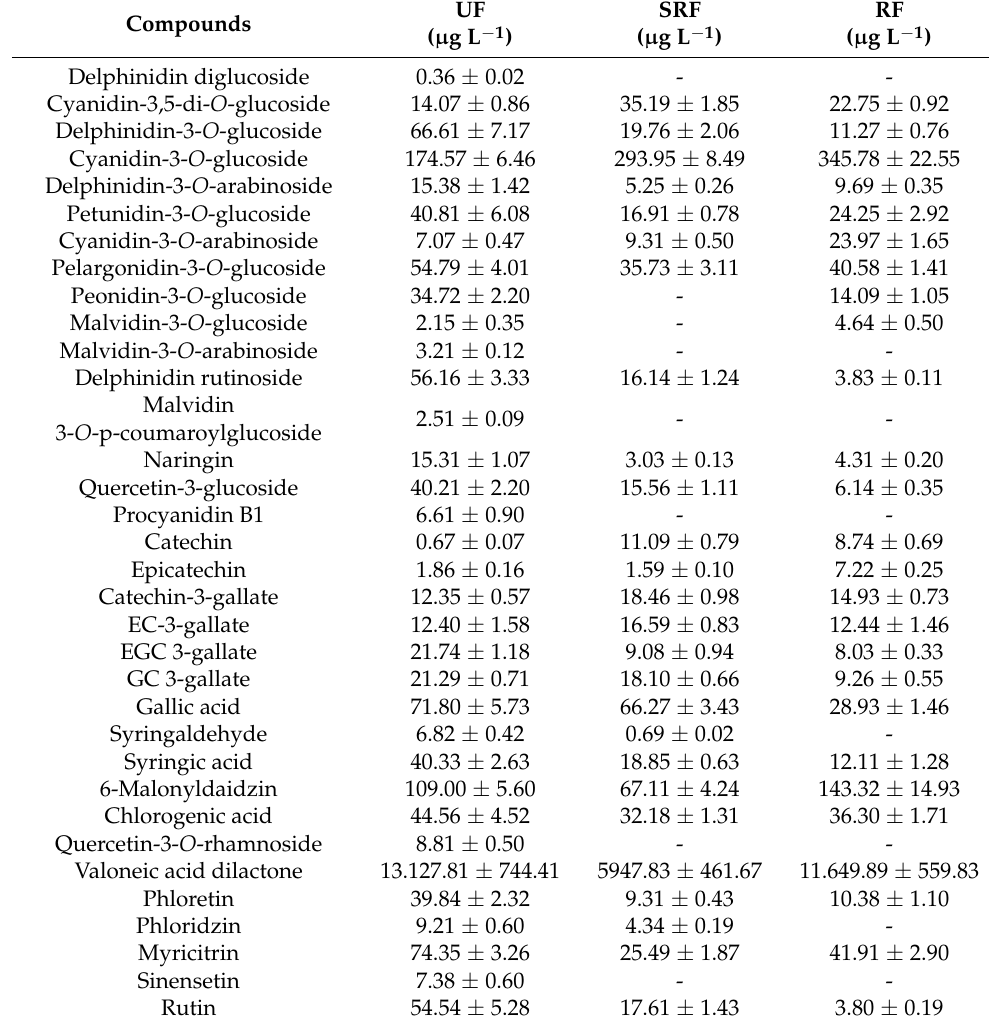
Table 2. Variation of phenolic composition in seeds of Phlegrean mandarin during fruit ripening (unripe fruits—UF, semi-ripe fruits—SRF, ripe fruits—RF). Values are means of five replicates ±